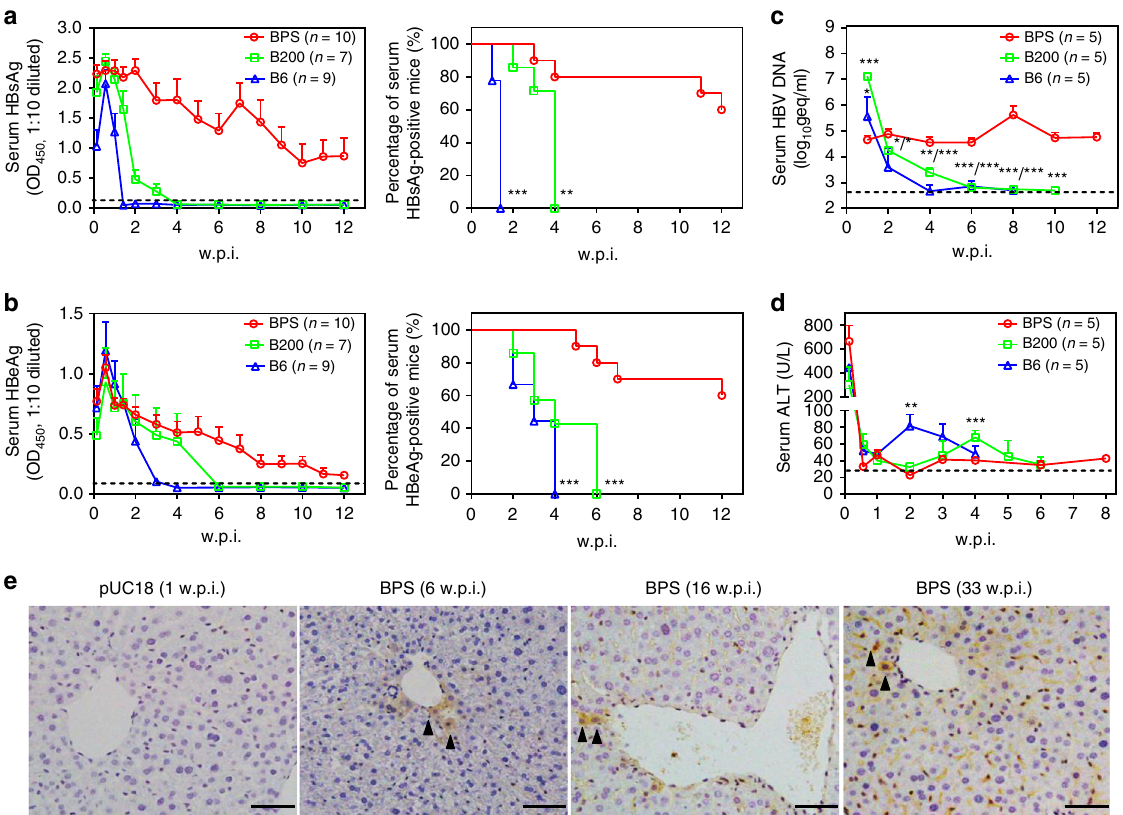
Fig. 1 BPS persistence in BALB/c mice. Sera from BPS, B200 or B6 HDI mice were analysed for HBsAg ( a ), HBeAg ( b ), HBV DNA ( c ) and ALT ( d ). Group means and s.e.m. within group are presented with group sizes ( n ) indicated. Group positivity percentage data are also plotted for HBsAg ( a , right panel) and HBeAg ( b , right panel). Dotted lines represent cut-off thresholds ( a , b , left panels), lower limit of quanti fi cation ( c ) or pre-injection baseline ( d ), respectively. B6 and B200 data are compared against BPS and statistical signi fi cance calculated using log-rank (Mantel – Cox) test ( a , b , right panels) or unpaired two-tailed t -test ( c , d ). * p < 0.05; ** p < 0.01; *** p < 0.001. e Liver sections taken from control and serum HBsAg positive BPS HDI mice were stained for HBsAg (arrow heads) in addition to H&E staining. Representative images from 2 mice are shown. w.p.i. weeks post injection. geq